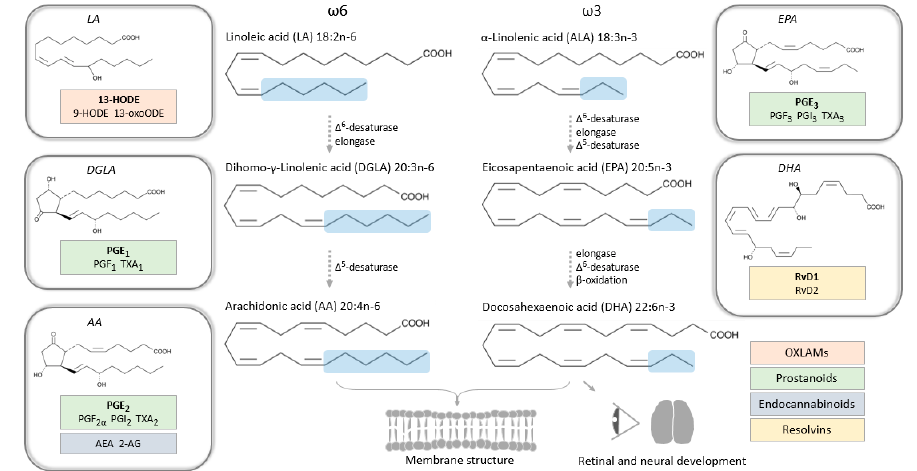
Figure 2. Biosynthesis of omega-6 and omega-3 PUFAs from dietary supplies in mammals, with examples of critical metabolites (bioactive lipids) in pregnancy framed in boxes. Abbreviations: HODE, hydroxyoctadecadienoic acid; oxo-ODE, oxooctadecadienoic acid; PG, prostaglandin; TX, thromboxane; AEA, arachidonoylethanolamide; AG, arachidonoylglycerol; Rv, resolvin; OXLAMs, oxidized linoleic acid